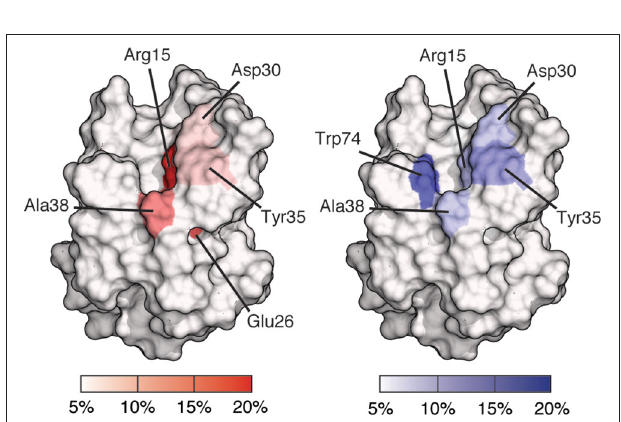
FIGURE 4 | Site maps of a BambL subunit showing binding site residues involved in docked pose interactions. Residues involved in 5% or fewer interactions are colored white; residues involved in 20% or greater interactions are colored red (for hydrogen bonding) or blue (for van der Waals). Residues with intermediate involvement are shaded according to the color